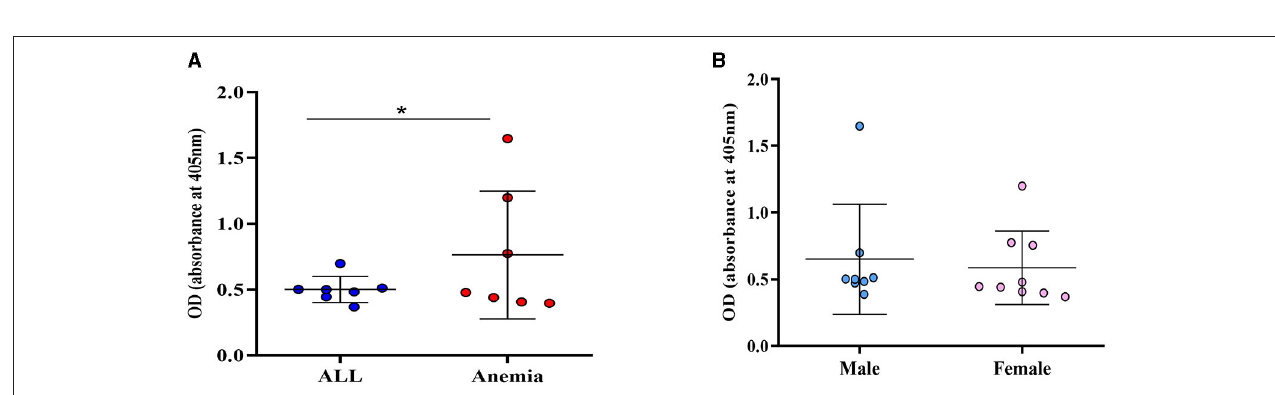
FIGURE 2 | Prevalence of CMV infection according to age (A) . Number of CMV-infected patients according to hematological disease (B) and sex (C) (* p = 0.02, One-way ANOVA and Student’s t -test).